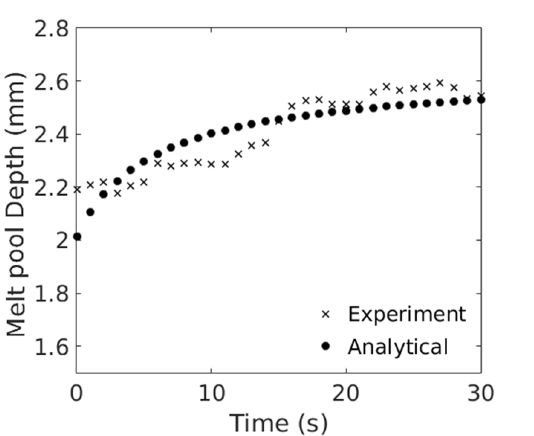
Figure 6. Comparison of analytically calculated transient melt pool evolution with experimental